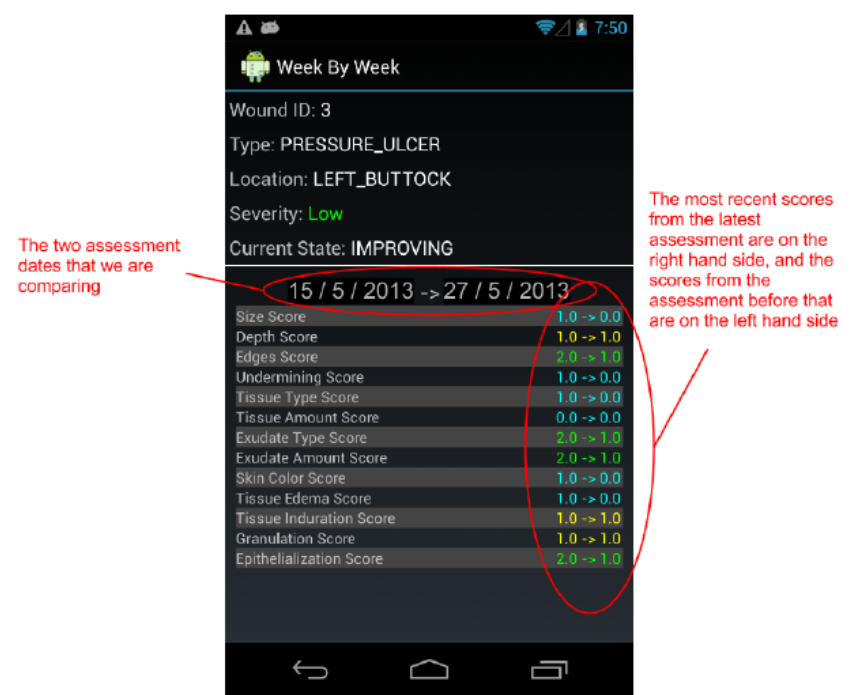
Figure 8. The Week-by-Week Comparison screen compares the last two assessments for a selected wound in more detail. It compares the score for every field in the two assessment